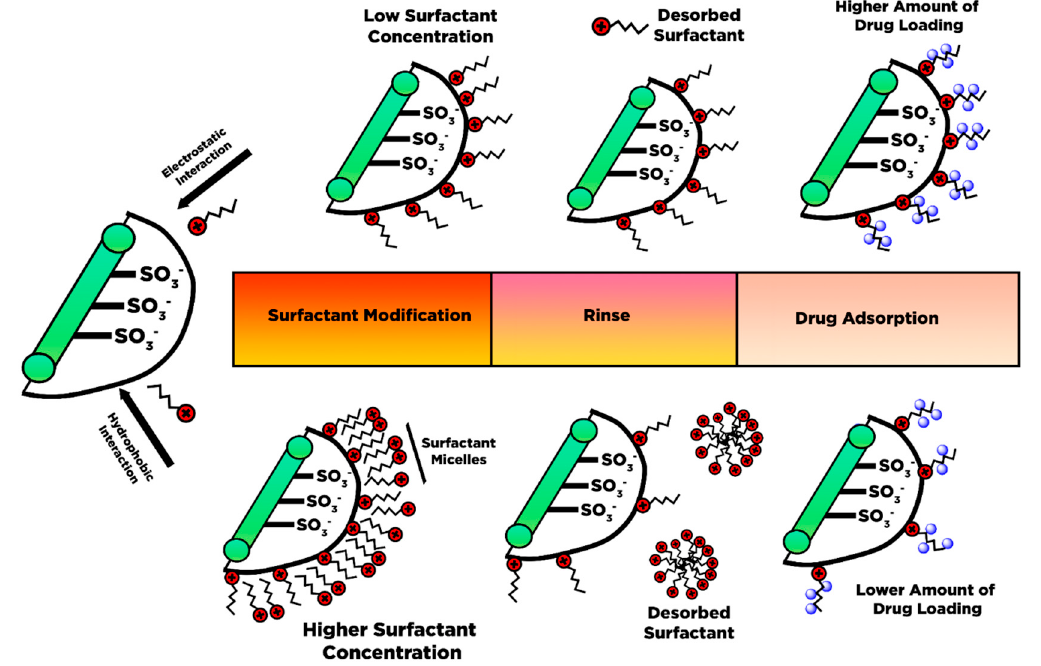
Figure 9. Schematic representation of the surfactant and nanocrystalline cellulose mechanism and its effect on drug adsorption (this figure is re-drawn from Bundjaja et al. [26]. Copyright © 2020 Elsevier B.V.).